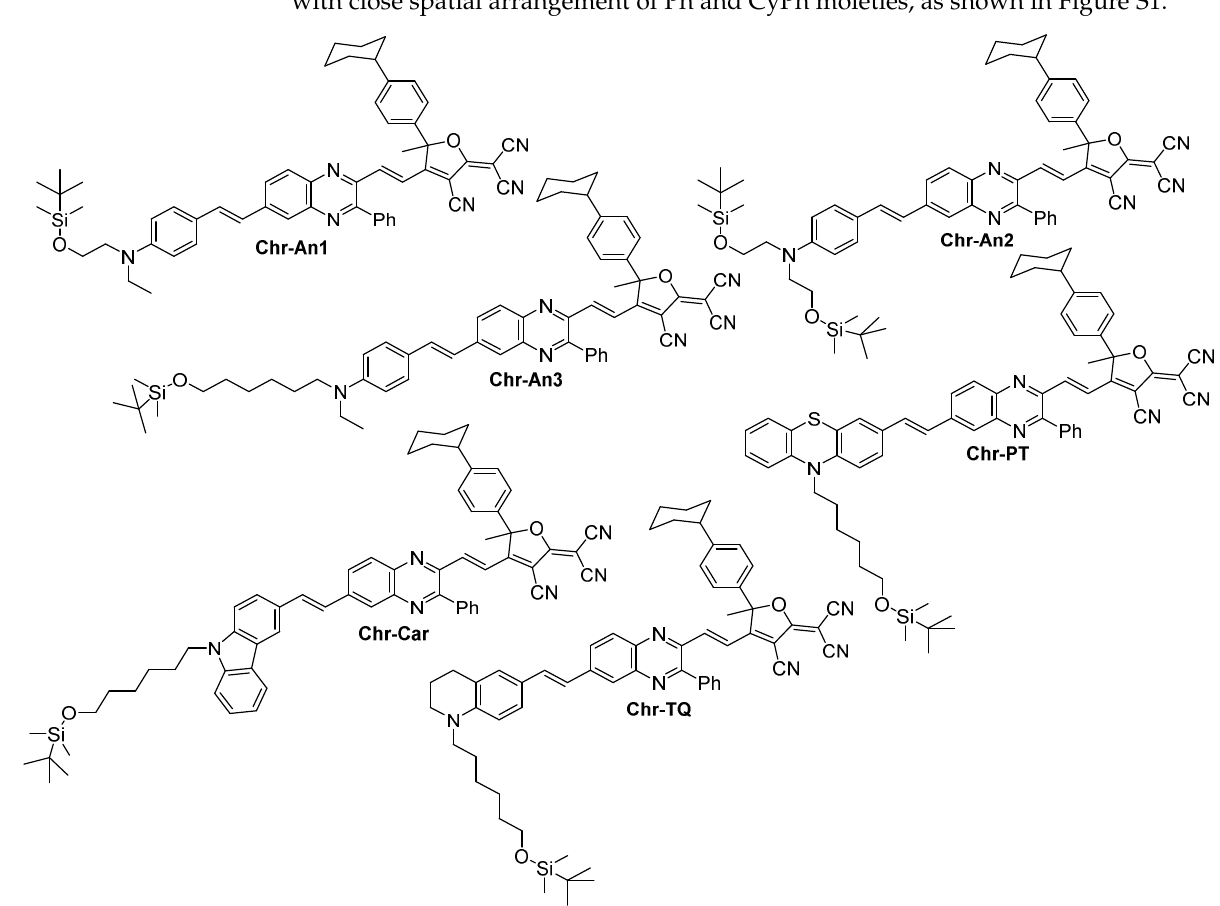
Figure 1. Quinoxaline-based NLO chromophores with various donors containing TBDMSO